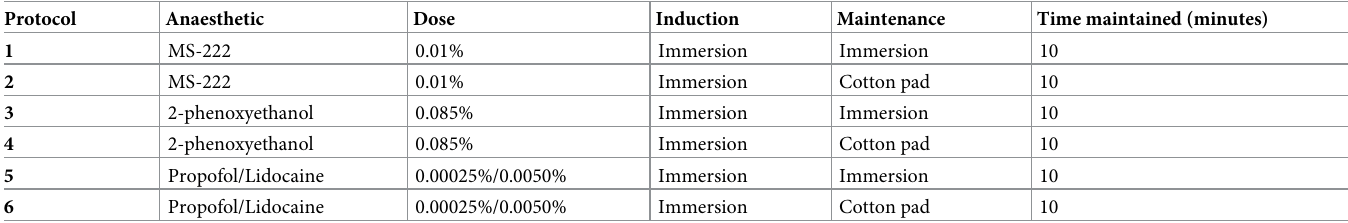
Table 1. Protocol numbers and the corresponding